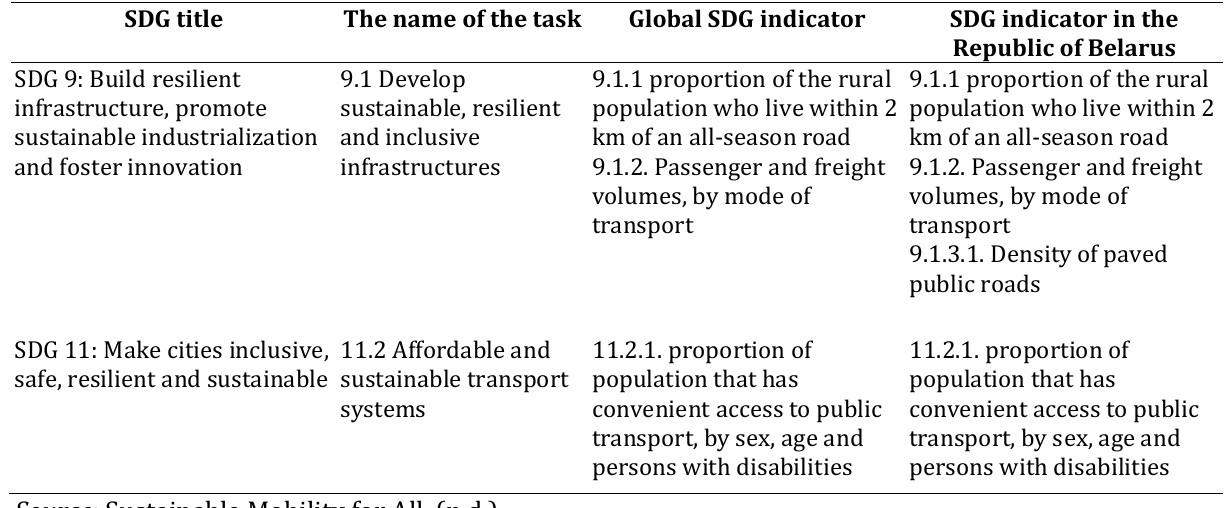
Table 1: List of universal access